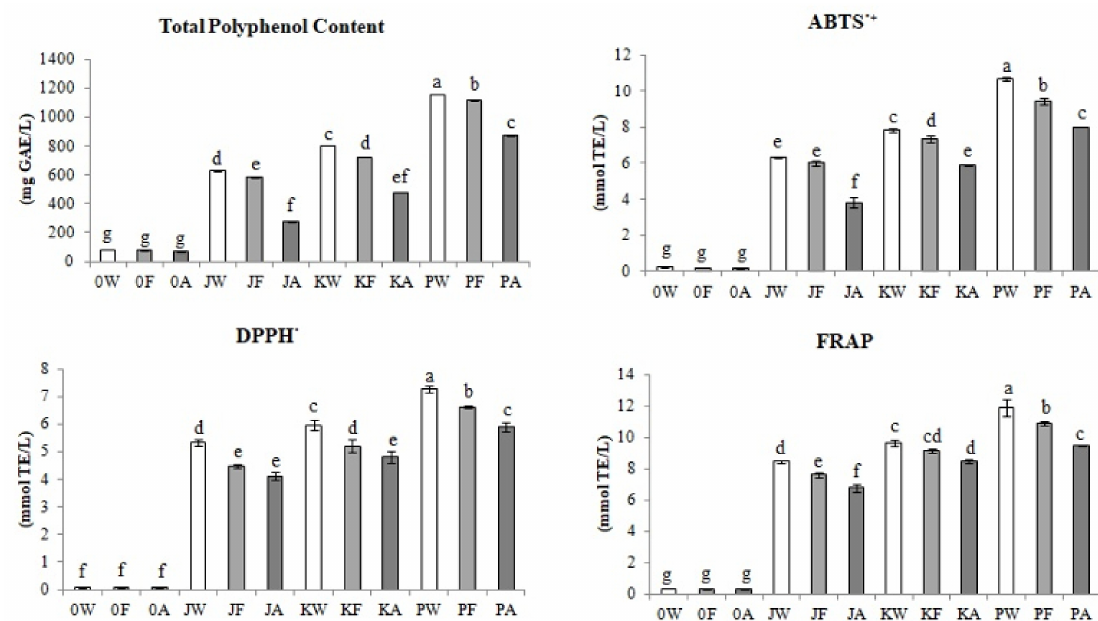
Figure 1. Changes in total polyphenols content (mg GAE/L) and antioxidative activity (mmol TE/L) measured by ABTS · + , DPPH · and FRAP tests during control and fruit meads production technology. White bars—worts (W), light gray bars— samples after fermentation (F), dark gray bars—meads after aging (A). Sample codes: 0—control, J—samples with ‘Jantarnyi’ juice, K—samples with ‘Koralowyi’ juice, P—samples with ‘Podolski’ juice. Mean values with different letters: a, b, c, d, e, f are statistically different ( p <